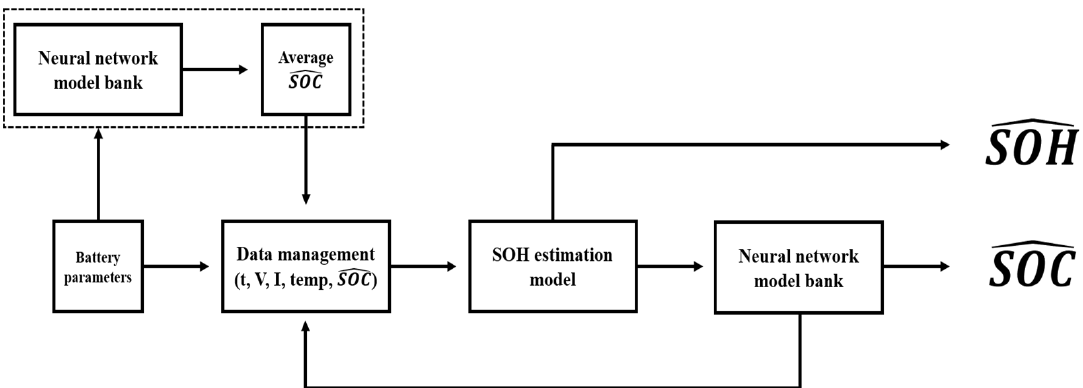
Figure 5. Process of proposed SOC and SOH estimation with a neural network model bank.